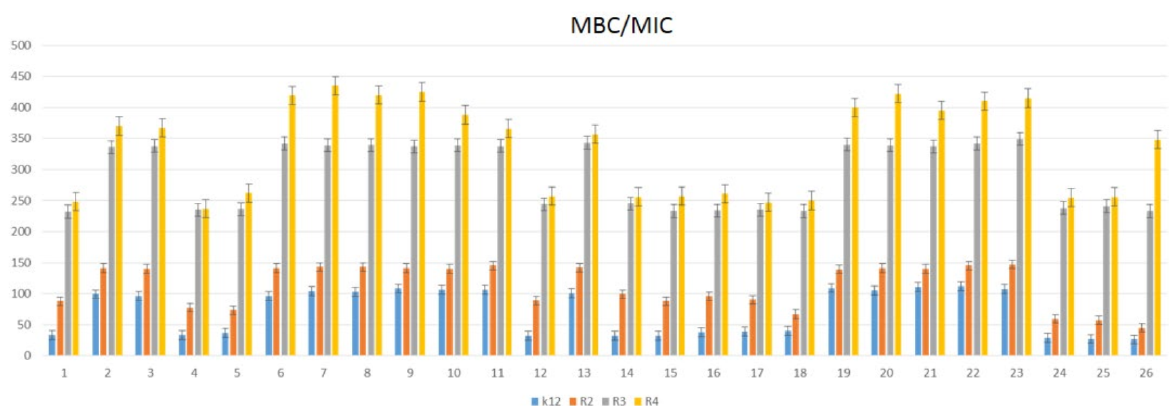
Figure 5. MBC/MIC of the amidoxime derivatives 1 – 26 in model bacterial strains. On the x -axis, compounds 1 – 26 are used sequentially. The y -axis shows the MBC/MIC value in µ g/mL − 1 (see Supplementary Materials). Each experiment was performed independently in 3 replications ( n = 3). Table 1. Statistical analysis of all analyzed compounds by MIC, MBC, and MBC/MIC; <0.05 *, <0.01 **, <0.001 ***. No. of